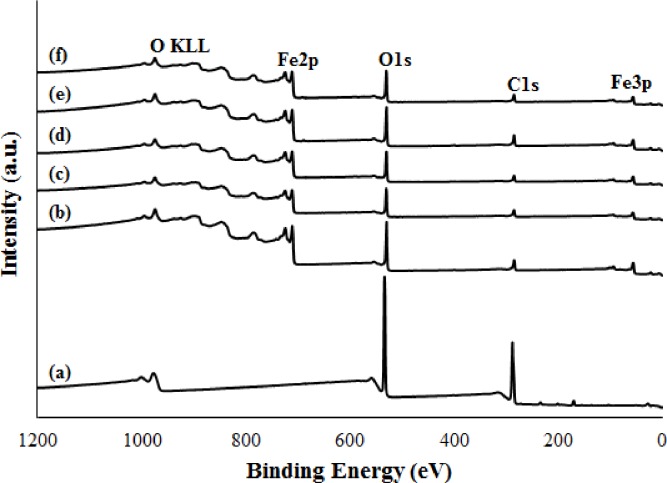
XPS survey spectra of (a) GO, (b) M-rGO3, (c) M-rGO6, (d) M-rGO12, (e) M-rGO18 and (f) M-rGO24.